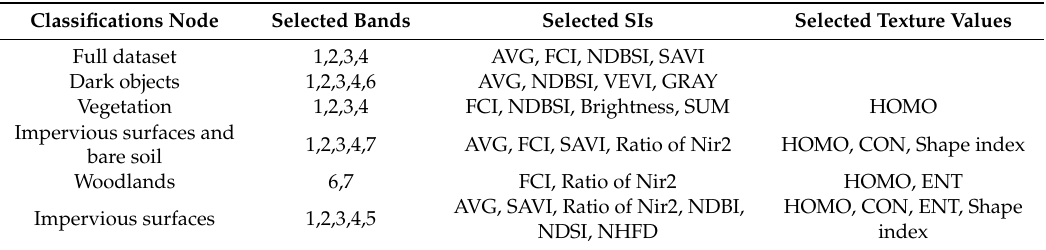
Table 2. Selected bands, SIs and textures for each classification node corresponding to Figure